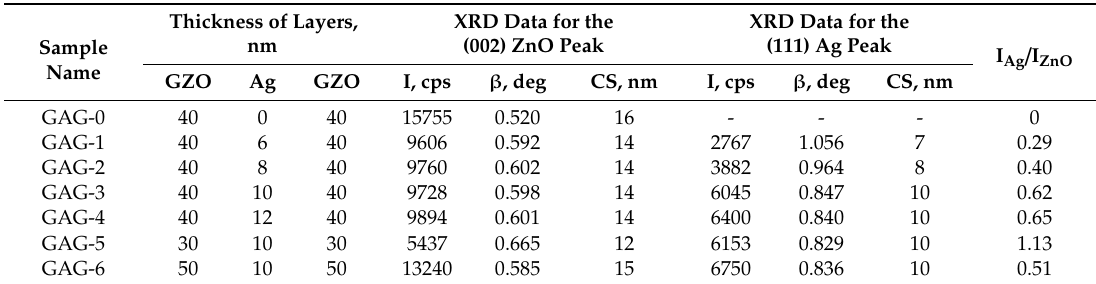
Table 2. XRD data for GAG multilayer